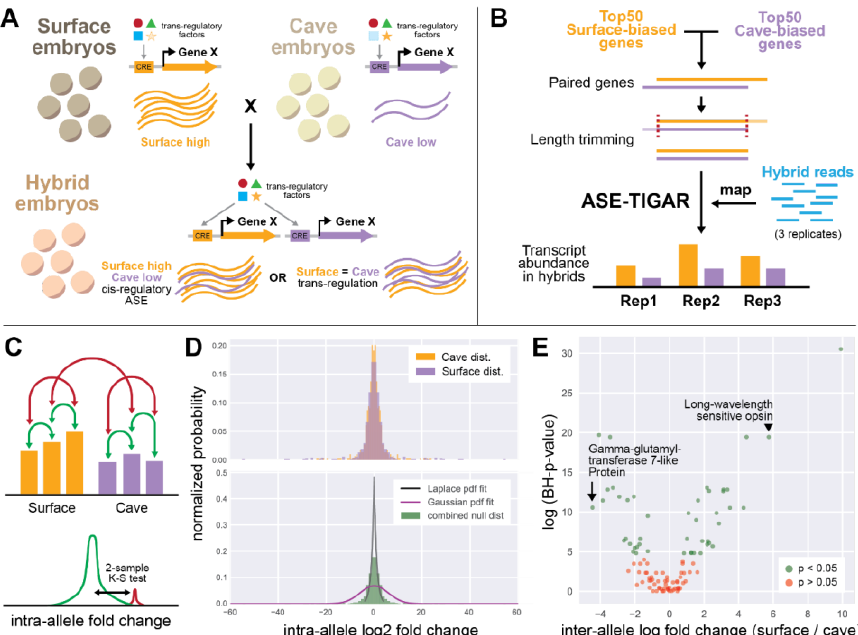
Figure 2. Experimental design of allele-specific expression analysis. ( A ) A hypothetical example of gene X, which is differentially expressed between cave versus surface individuals and also shows allele-specific expression with lower expression of the cave allele. In this case, the underlying mechanism may be a result of differences between trans-regulatory factors between populations, or in the cis-regulatory sequence. If cis-regulatory mechanisms dominate, then we expect to see similar surface-biased expression in hybrids. However, if trans-regulatory mechanisms dominate, then the equalized trans-regulatory environment in hybrids will result in no allele-specific expression. ( B ) Pipeline of allele-specific expression (ASE) analysis. The top 50 differentially expressed genes, in both directions, present in both the cave and surface transcriptomes were selected, paired genes were trimmed to the same length, and hybrid reads were mapped to the trimmed cave and surface versions of each gene. ( C ) Intra-allele log2 fold change was calculated by comparing transcript abundance between replicates of a given allele (green arrows). This null distribution (green curve) was then compared to distributions of inter-allele log2 fold change (red arrows, red curve) using a two-sample Kolmogorov–Smirnov test. ( D ) Intra-allele log2 fold change distributions for cave and surface populations. The top panel shows each allele separately, overlapped. These distributions were determined to be indistinguishable (K–S test, see Methods). The bottom panel shows the combined distribution (green), and a Laplace fit (black line) and Gaussian fit (magenta line) to the distribution. The combined null distribution does not neatly fit either a Laplace or Gaussian distribution, validating that the two-sample Kolmogorov–Smirnov test is appropriate, as it does not assume that either distribution is parametric. ( E ) The analysis identified 45 genes that had significant allele-specific expression (green) and 55 genes that did not have significant allele-specific expression.